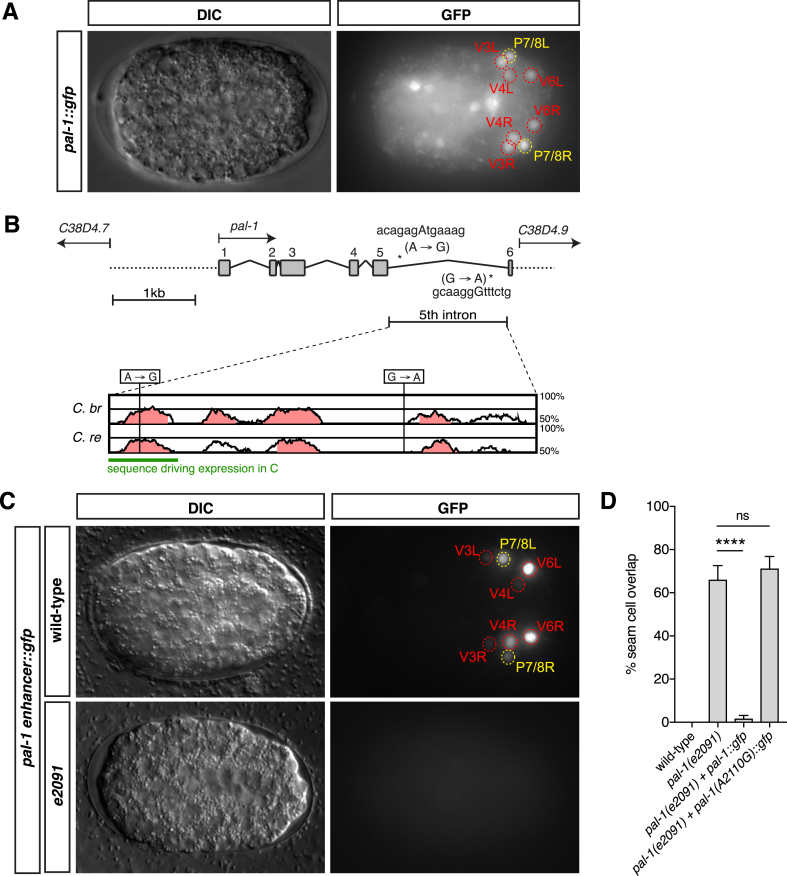
Expression of pal-1::gfp in V seam and P cells is dependent on expression driven from a pal-1 intronic enhancer, perturbed in e2091.A. Ventral view of embryos at dorsal intercalation carrying the wild-type rescuing full-length pal-1::gfp construct. Expression can be observed in multiple cells including V3, V4 and V6 and P7/8 (the duration of this expression is represented in Fig. 5B). B. The genomic structure of pal-1. Exons are represented as grey boxes, and the positions of the two point mutations in the last intron in e2091 are indicated by asterisks. Conservation of the pal-1 5th intron, containing the two point mutations of e2091, between two members of the Caenorhabditis species, C. briggsae and C. remanei is shown below (generated using Frazer et al., 2004). A green stripe indicates the sequence cloned and used to assess enhancer function in vivo. C. Ventral view of embryos at dorsal intercalation carrying either the wild-type or e2091 mutated version of a construct containing three copies of the first conserved non-coding element of the last pal-1 intron (sequence indicated in B in green). The wild-type enhancer-only construct is able to drive GFP specifically in V3 and P7/8 sister nuclei, as well as the pair of sisters V4 and V6. Conversely, the construct carrying the e2091 version of the putative enhancer is unable to drive GFP expression. The GFP images represent maximum intensity projections of a z stack through the whole embryo; DIC images comprise a single representative z slice that corresponds to cells expressing GFP. D. Rescue of pal-1(e2091) L1 seam cell phenotypes by pal-1::gfp is eliminated by the introduction of the e2091 point mutation A2110G into the 5′ intronic enhancer [n ​> ​50, ****P ​< ​0.0001, two-tailed Student’s t-test].